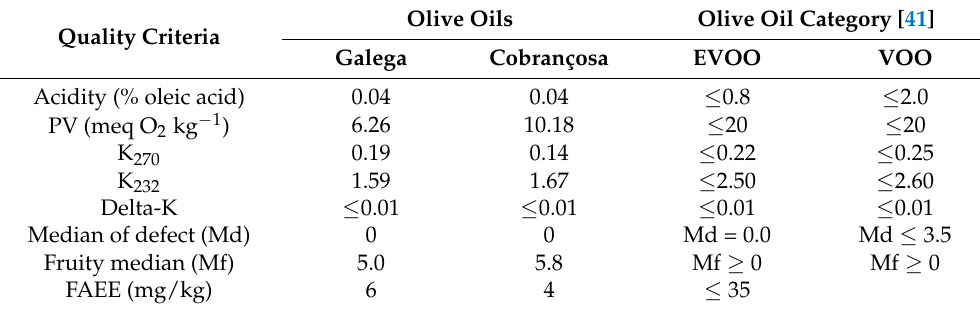
Table 1. Acidity, peroxide value (PV), UV absorbances (K 270 , K 232 , and delta-K) and fatty acid ethyl esters (FAEE) quality characteristics for Galega and Cobrançosa oils at the beginning of experiments (t0) and the legal limits for commercial virgin olive oils (Extra Virgin Olive Oil (EVOO) and Virgin Olive Oil